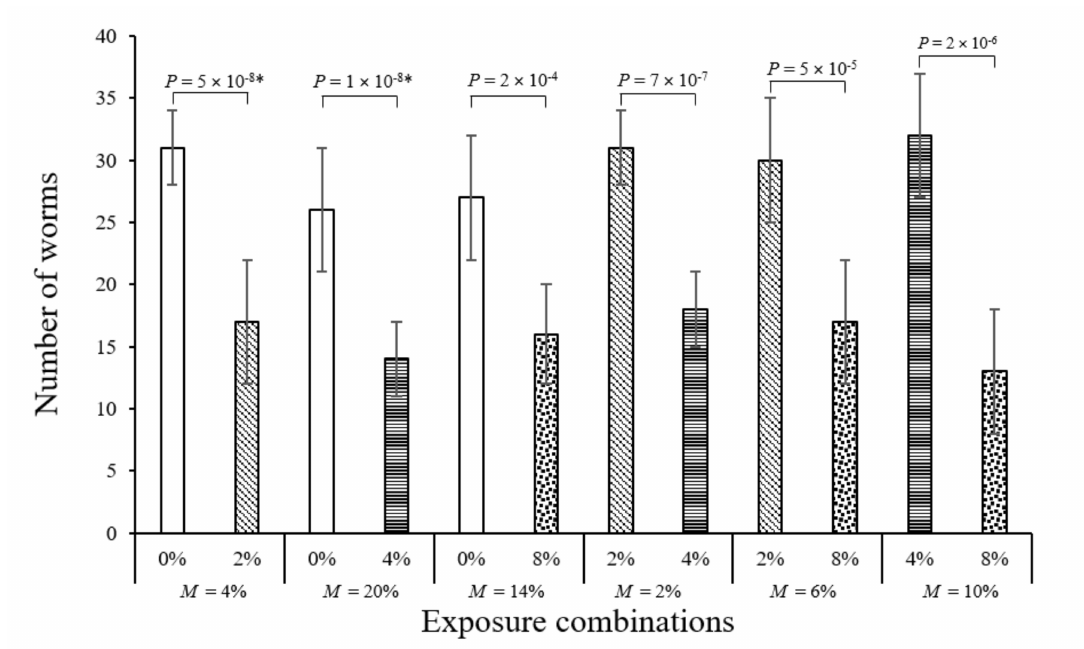
Figure 2. Worms counted in non-spiked and MP-spiked areas of the avoidance test vessel. Data represent mean worm count per area ± standard deviation ( n = 15, at 50 worms per independent